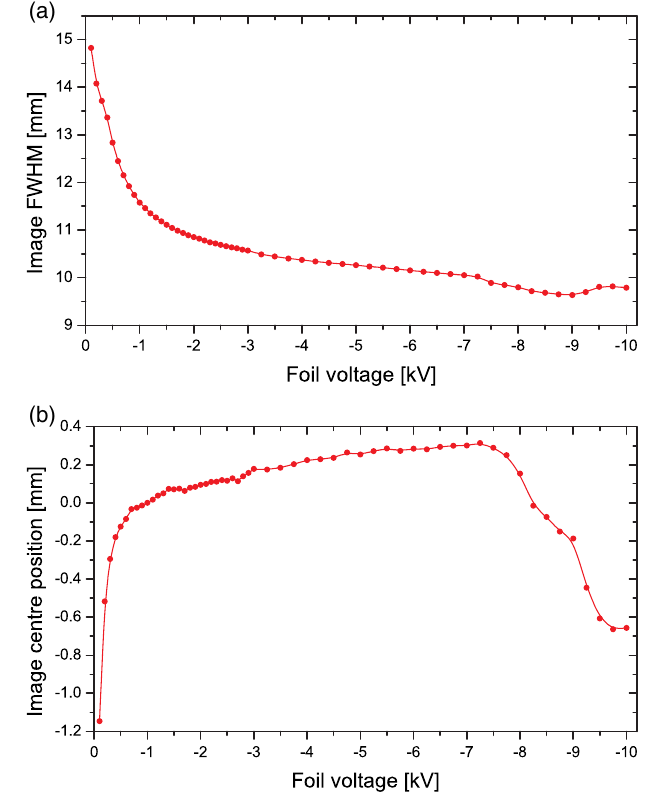
FIG. 10. Beam image FWHM (a) and center displacement relative to the beam position at (cid:1) 1 kV (b) as a function of the voltage applied to the